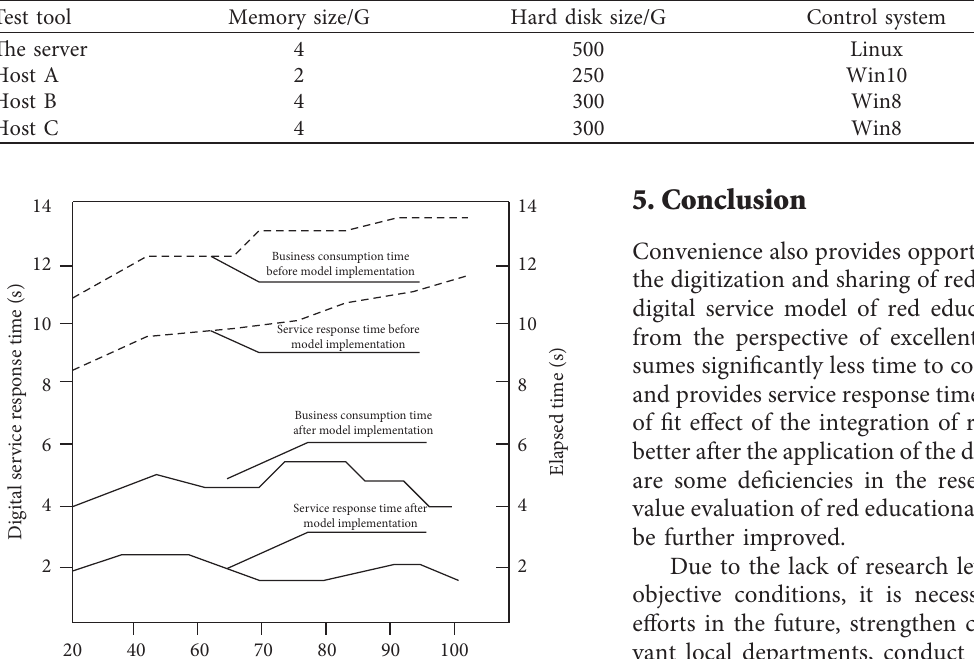
Table 1: Experimental environment settings.